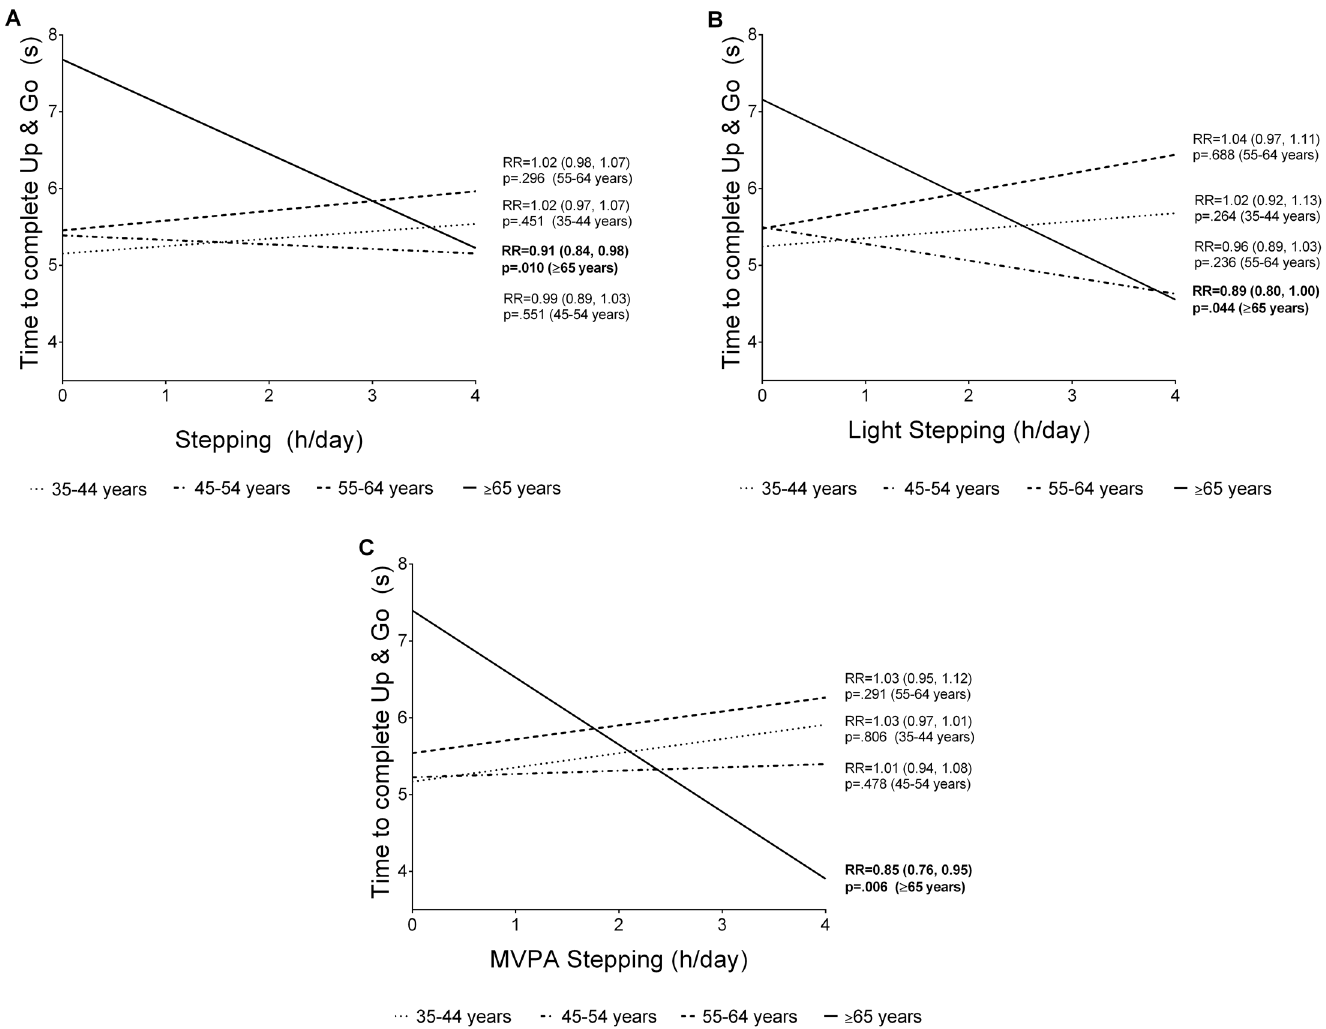
Fig 1. Age-group interactions for the association of Timed Up and Go (TUG-8) performance and overall stepping (A), light stepping (B), and MVPA stepping (C) in Australian adults aged 36 – 80 years.